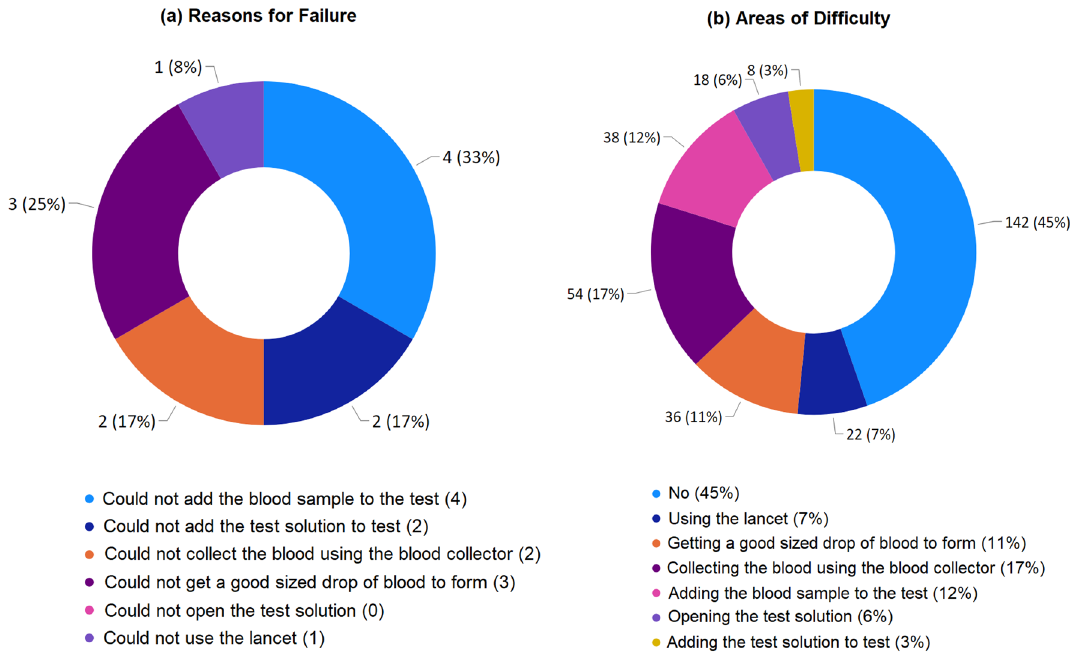
Figure 7. Summary for: ( a ) reasons for failure to complete the test based on 12 multiple choices; ( b ) areas of difficulty during the test based on 318 multiple choices.